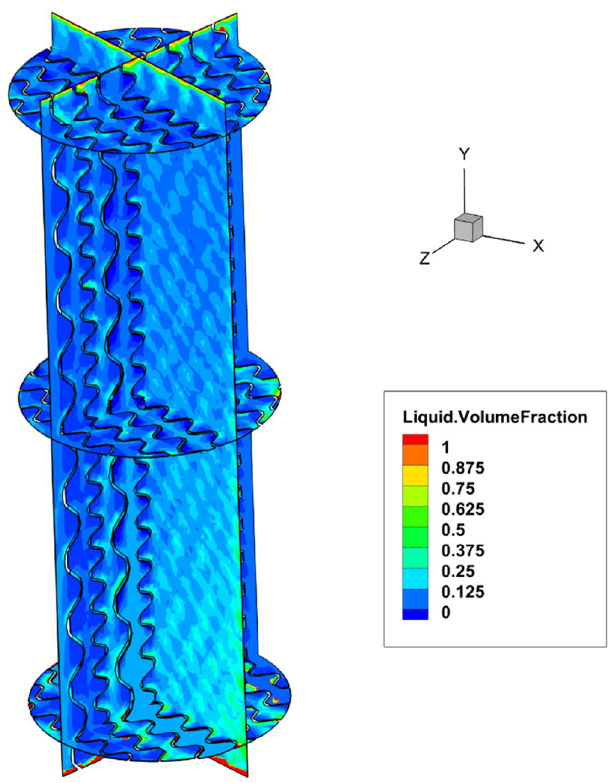
Figure 3. Liquid distribution around the PACK-1300XY obtained by the three-dimensional modeling (liquid flow rate = 7.5 m 3 /m 2 h, F-factor = 1.2 Pa 0.5